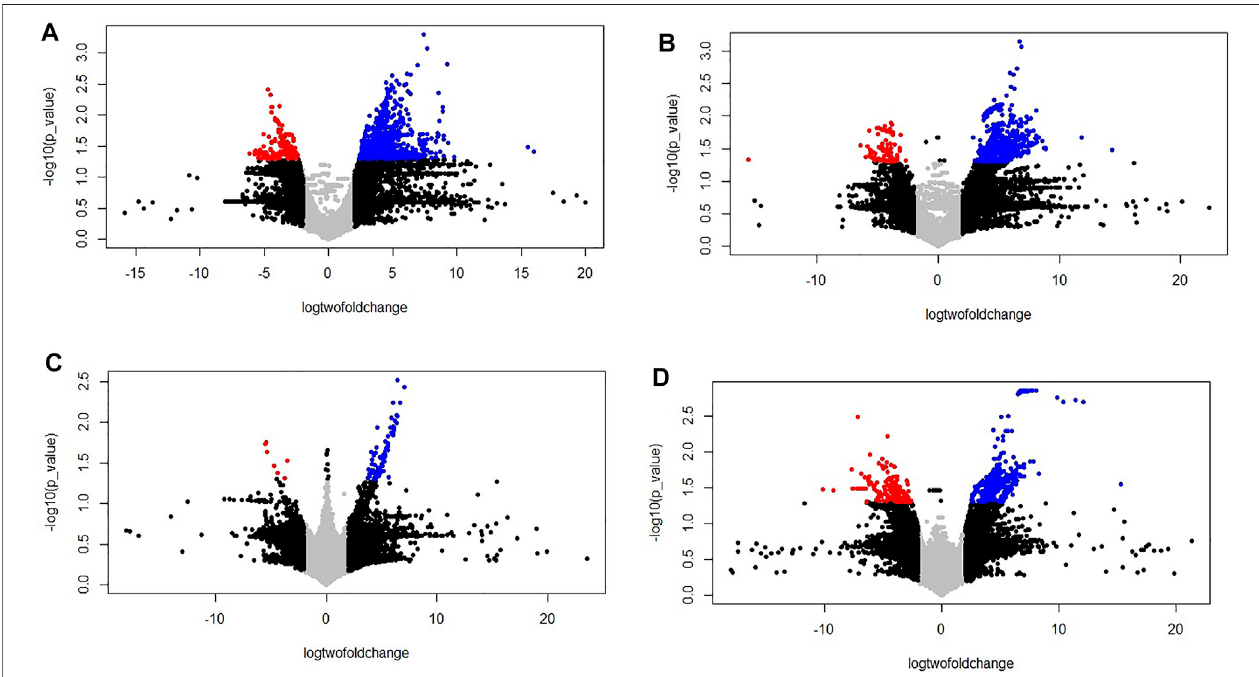
FIGURE3| Volcano plotofthedifferentially expressed genes(controlvs. stressed) inthetwogenotypes PBW677and PBW703for each tissue investigated in this work. (A) Volcano plot of gene expression in the ef fi cient genotype in roots and (B) shoot/leaves; (C) Volcano plot of gene expression in the inef fi cient genotype in roots and (D) shoots/leaves. *The two vertical dotted lines are twice the difference threshold ( < -2 or > 2), and the horizontal dotted line represents signi fi cance level of -log ( p -value = 0.05) 1.30. Red dots indicate the downregulated genes, blue dots indicate the upregulated genes, black dots represent non-signi fi cantly differentially expressed genes surpassing the threshold absolute log2 fold change ( ≥ 2) or signi fi cantly expressed genes with lower absolute log2 fold change ( ≤ 2) than the threshold, and grey dots indicate non-signi fi cantly expressed genes with lower absolute log2 fold change ( ≤ 2) than the threshold.